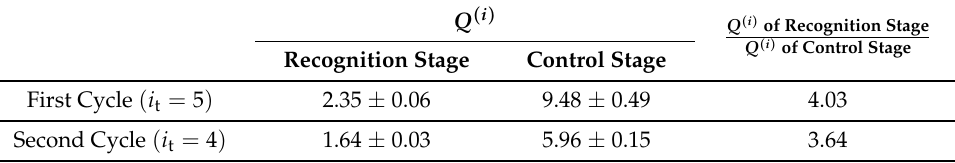
Table 2. Response factor Q ( i ) for recognition/control stages of the first/second cycles presented in Figure